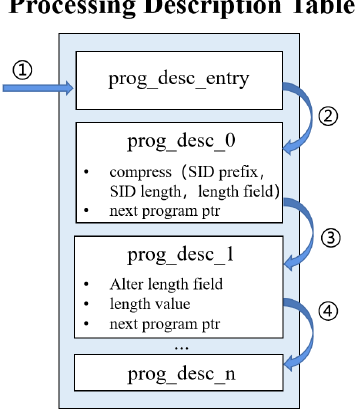
Figure 4. The uSID compression program in PDT.